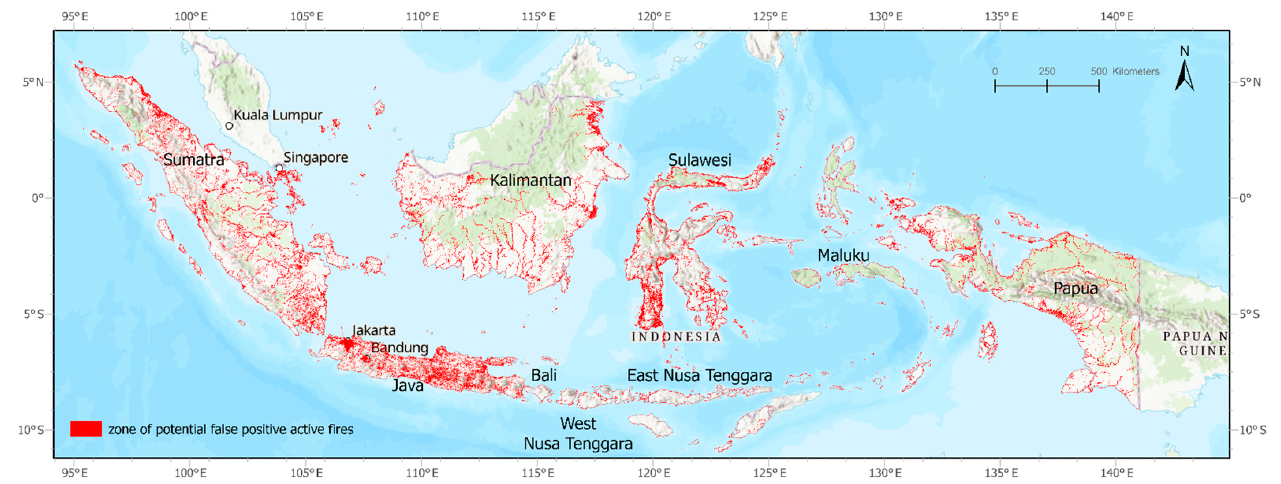
Figure 7. Zone map of potential false-positive active fires for biomass burning from low-spatial- resolution data.